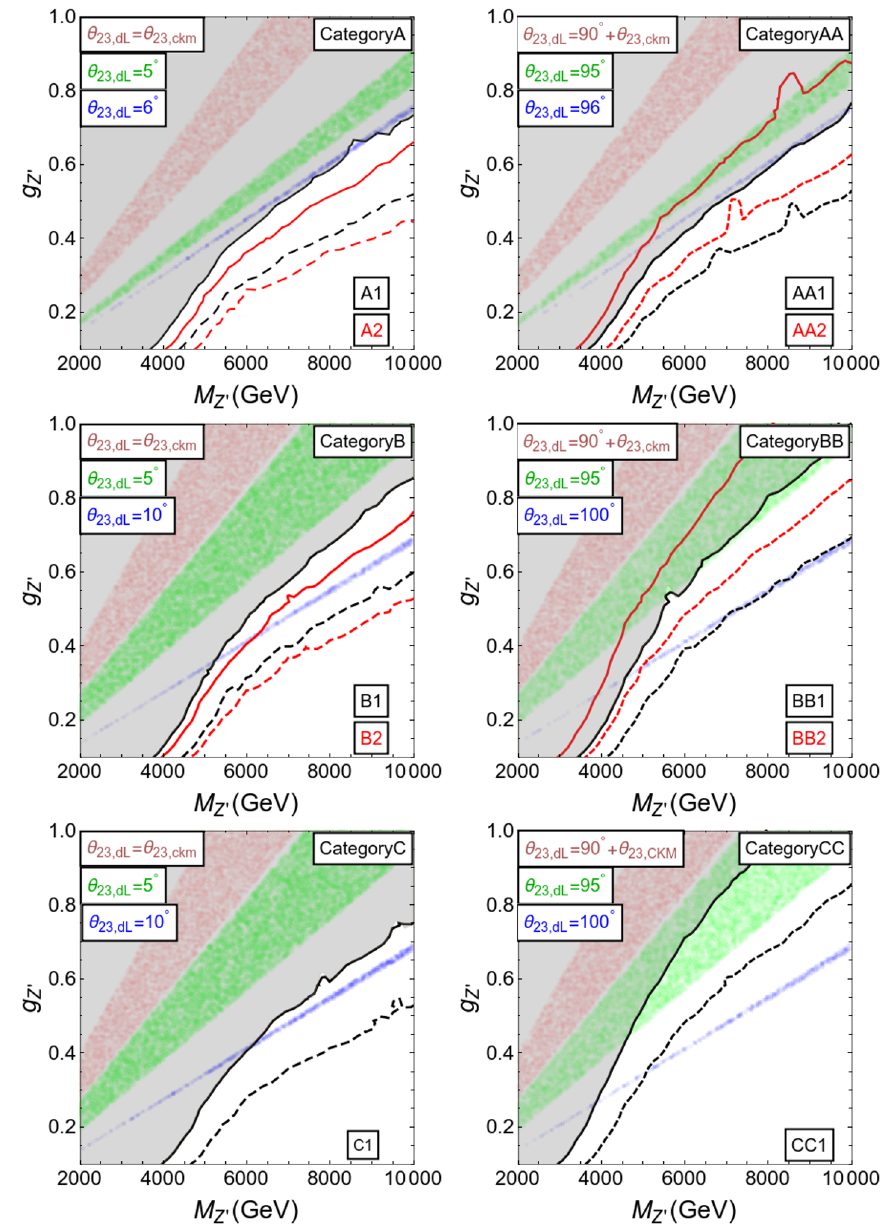
Figure 4 . The constraints in the ( M Z 0 , g Z 0 ) plane for the non-MFV scenarios, for fixed values of θ 23 ,dL . The pink, green, and blue coloured bands indicate the combined 2 σ -allowed regions from the b → s global fit [21] and neutral meson mixing data [30]. The regions above the solid lines are excluded to 95% C.L., with 140 fb − 1 total integrated luminosity, using dimuon searches [33]. The gray bands indicate the current 95% C.L. exclusion regions for scenarios A1, B1, C1, AA1, BB1 and CC1, in the respective plots. The dashed lines represent the reach of collider constraints with 3000 fb − 1 total integrated